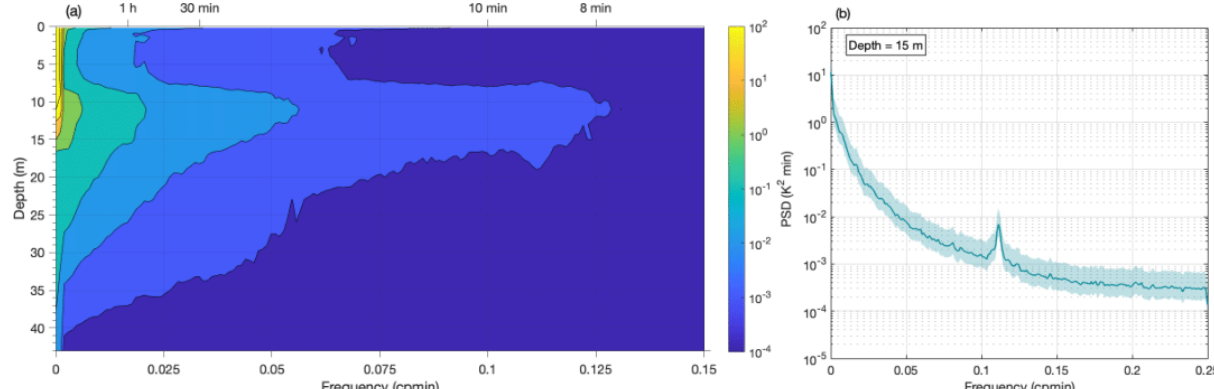
Figure 6. Power spectral densities computed from the 2min mean lake temperatures at depths from 0.2 to 43m (a) and for the depth of 15m (b) for the entire observation period. PSDs were computed as described in Sect. 3.2. The full line and shaded area in panel (b) show the PSD and 95% confidence interval, respectively. Frequencies are given in cycles per minute